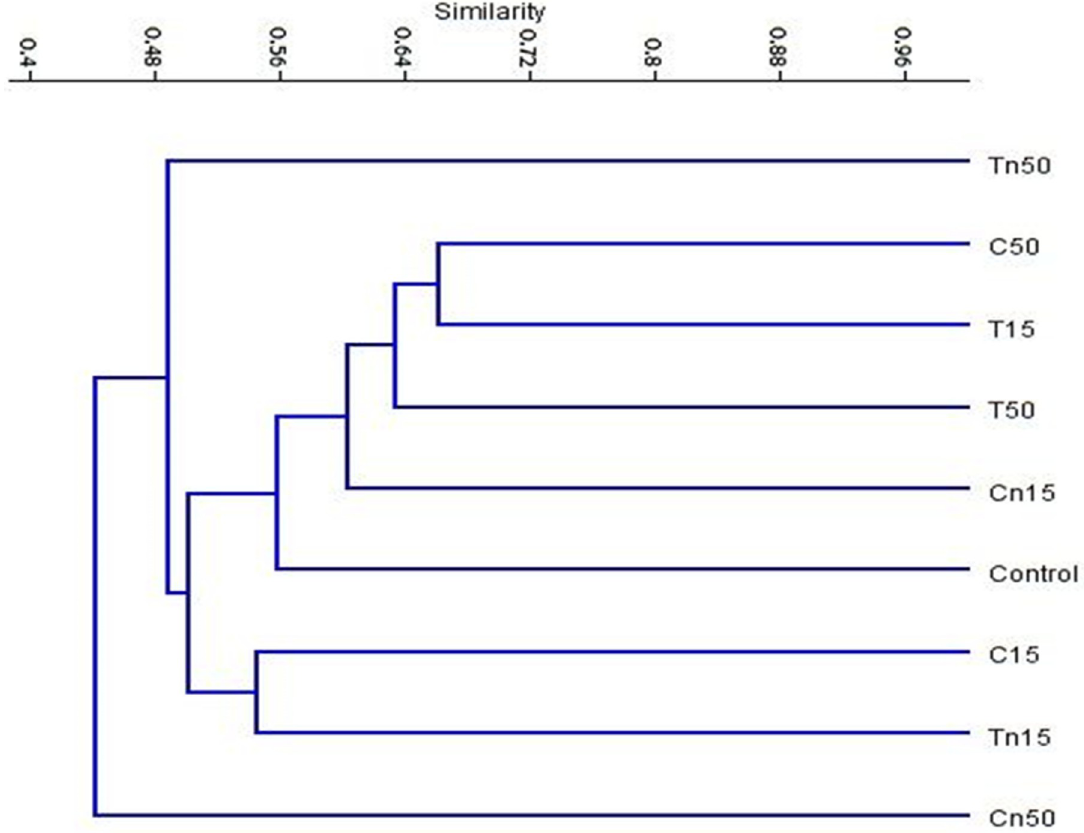
Fig 7. UPGMA cluster analysis based on Jaccard’s similarity coefficient of ISSR analysis of the nine treatments: C; Control, C15; chlorntraniliprole LC 15 , C50; chlorntraniliprole LC 50 , Cn15; nano-chlorntraniliprole LC 15 , Cn50; nano-chlorntraniliprole LC 50 , T15; thiocyclam LC 15 , T50; thiocyclam LC 50 , Tn15; nano-thiocyclam LC 15 and Tn50; nano-thiocyclam LC 50